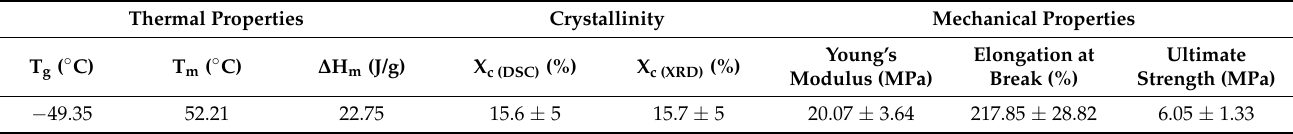
Figure 8. Tensile stress–strain curves of MCL-PHA terpolyester sample. (The repeated 3-time measurements took the data from the three specimens.) . Table 2. Physical properties of MCL-PHA terpolyester sample.